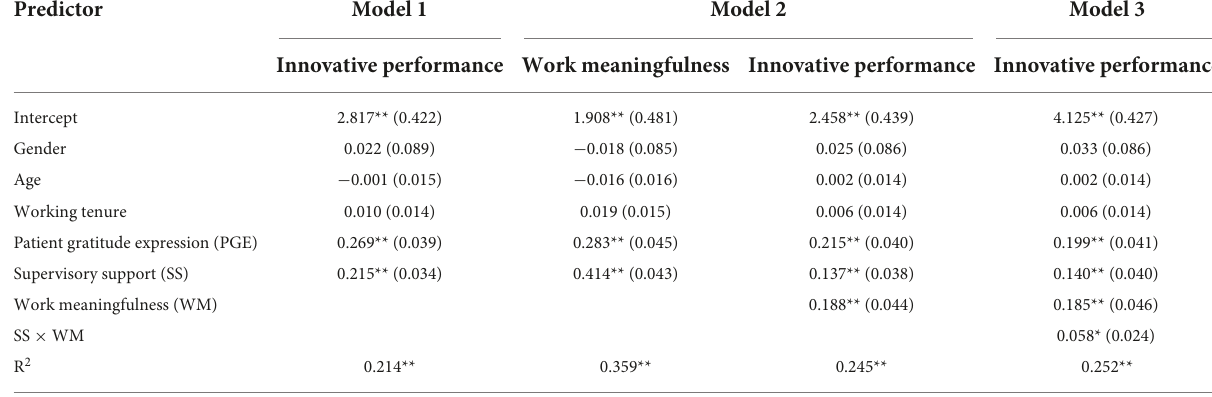
TABLE 3 Results of multiple hierarchical